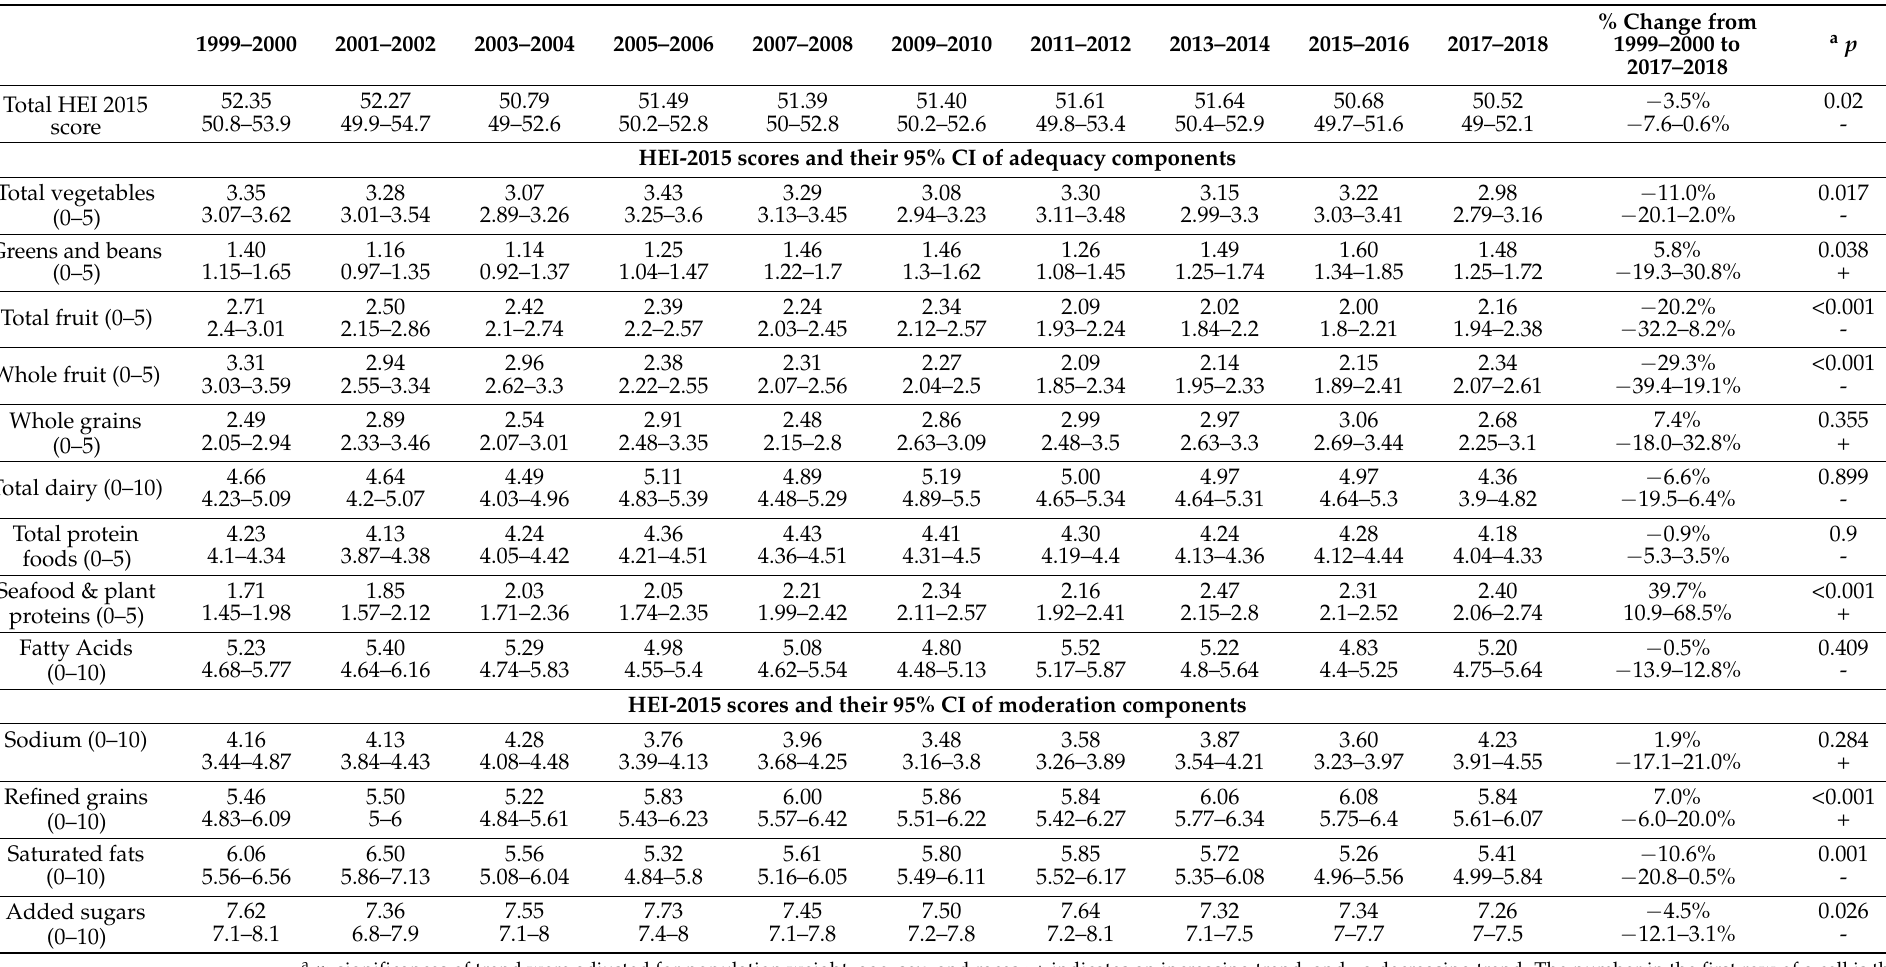
Table 2. Estimated means, their 95% CI, and trends of the total and component scores of Healthy Eating Index (HEI)-2015 of the US type 2 diabetic adults